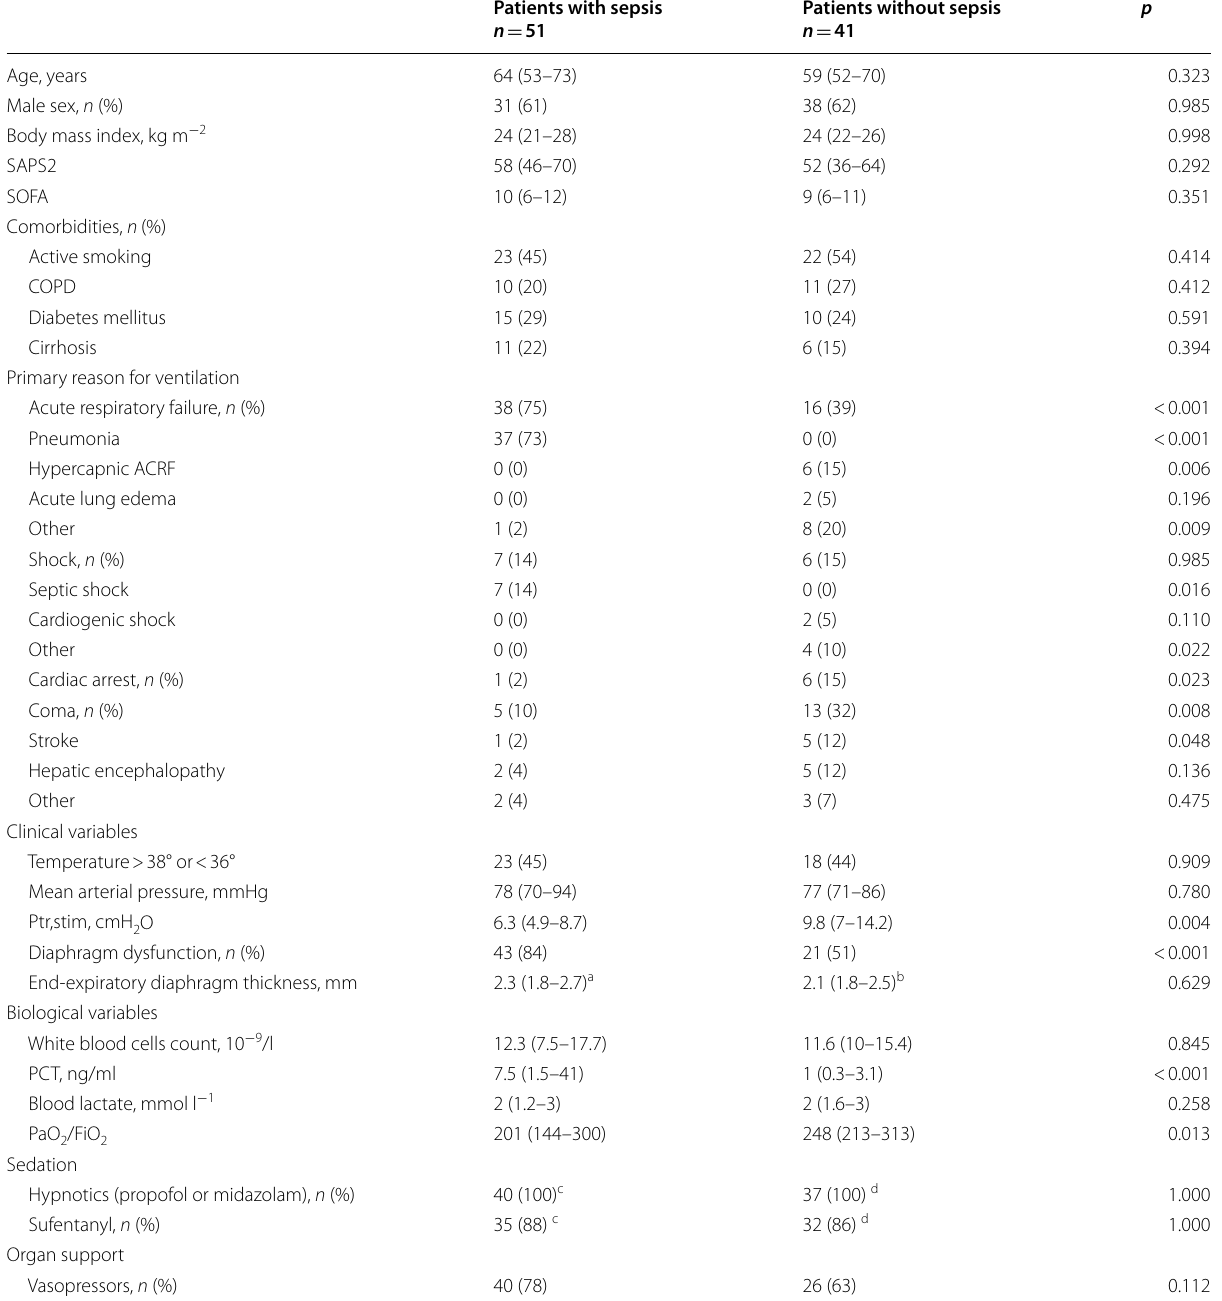
Table 1 Patients characteristics at